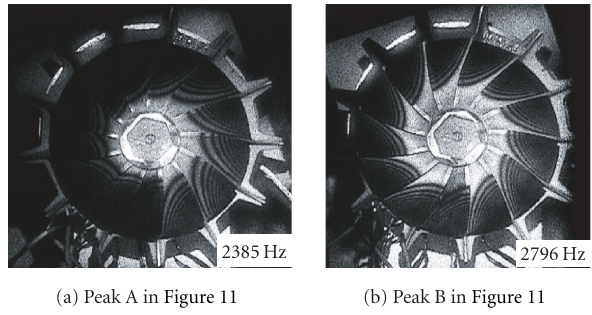
Figure 12: Modes of the turbine wheel excited by torsional excita- tion.